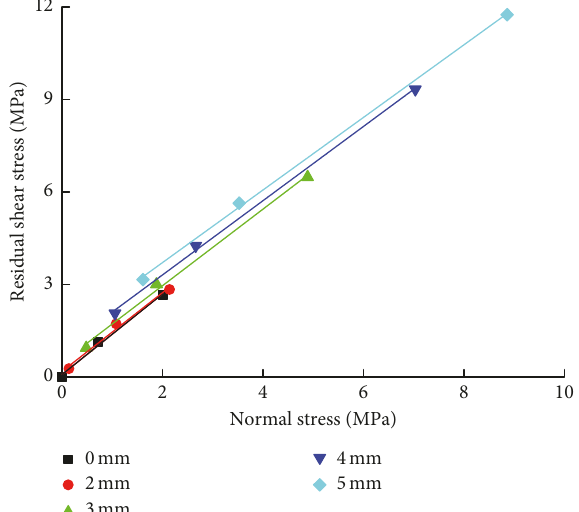
Figure 9: Residual shear strength envelopes of concrete blocks with and without bolt.